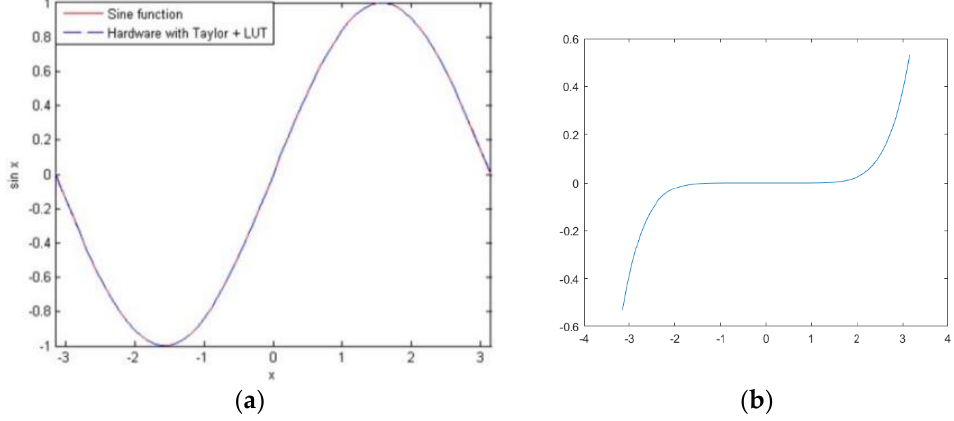
Figure 17. ( a ) The Taylor and LUT approximation of the sine function. ( b ) The error of the sine function and Taylor and LUT approximation.